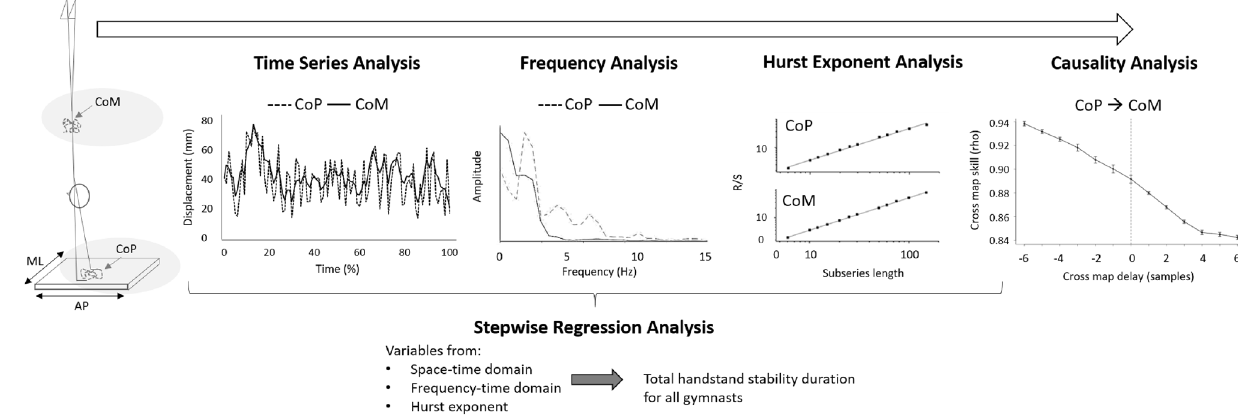
Figure 1. An overview image of the data analysis process to investigate CoP and CoM motion during the stabilising phase of a handstand for more skilled and less skilled gymnasts, in addition to a balance phase for the more skilled gymnasts. A representative trial of CoP and CoM is provided to illustrate each form of analysis.